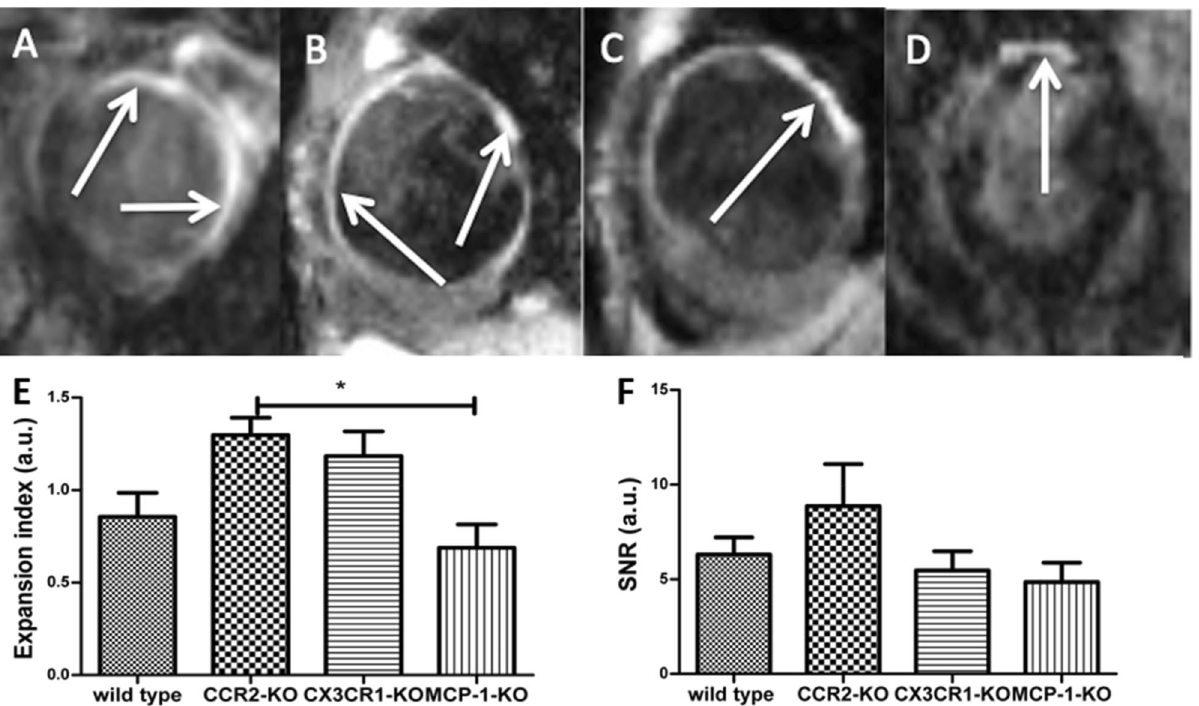
Figure 3. In-vivo follow up of elastin with the aid of cardiac MRI in wild-type mice 30 days after permanent ligation ( A ). The arrows represent ESMA uptake in exemplary images. Cardiac MRI image of CCR2-KO mice 30 days after permanent ligation ( B ). Cardiac MRI 30 days after permanent ligation in CX3CR1-KO mice ( C ). Cardiac MRI 30 days after permanent ligation in MCP-1-KO mice ( D ), ( E ) shows increased expansion index in CCR2-Ko mice compared to MCP-1-KO mice 30 days after MI as sign for increased myocardial scar with decreased ability of contraction. In ( F ) SNR was increased in CCR2-KO mice compared to MCP1-KO-mice 30 days after MI, although statistically not relevant also as a sign for extended myocardial scar.